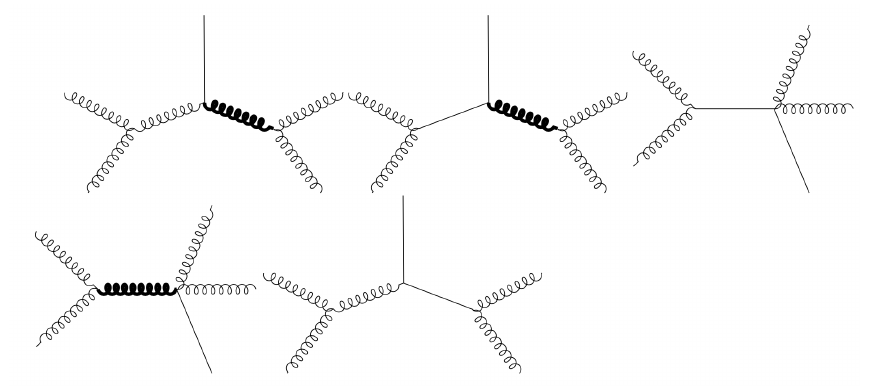
Figure 11 . The five types of diagrams for φAAAA process when m i + m j = 0 . The bold curly line represents a gluon and the straight line a scalar field.